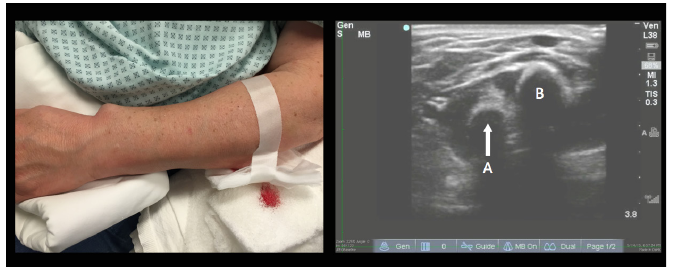
Figure 1. Open left forearm deformity with sagittal ultrasound image of the left forearm demonstrating a foreign body (A) radial to the ulna (B).